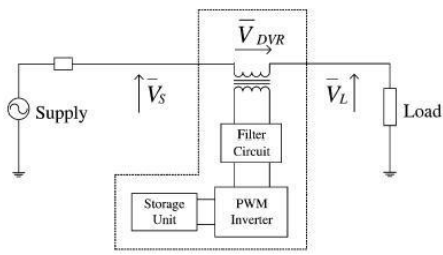
Fig.1. Block Diagram of DVR The detected sag voltage in the a-b-c